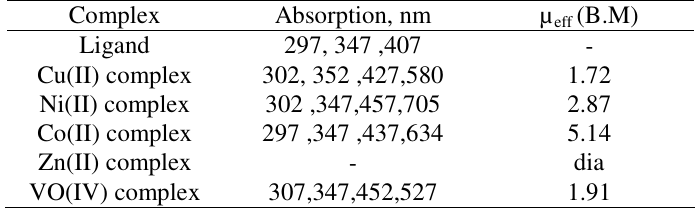
Table 3. Electronic spectra and magnetic susceptibility data for ligand and